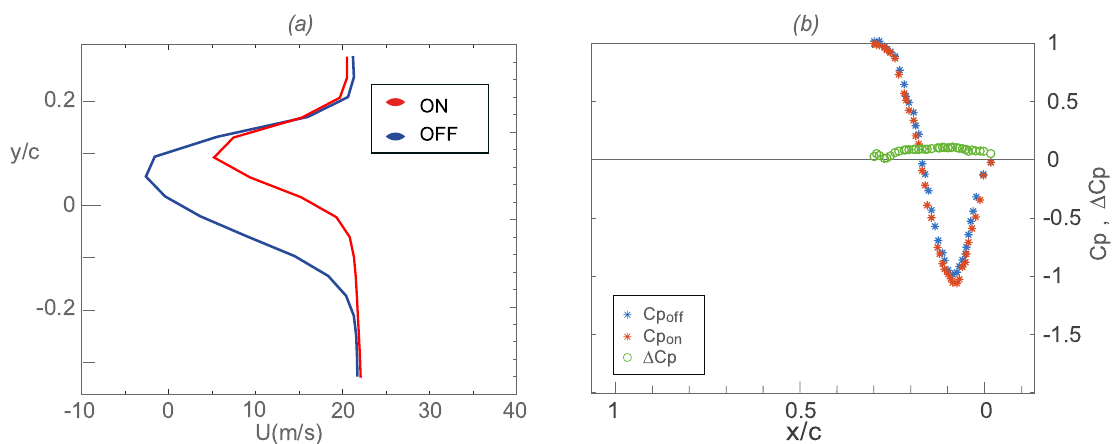
Figure 11. ( a ) Cross-wake velocity profile and ( b ) C P values at R for α = 14.5 ◦ and U ∞ = 20 m/s.